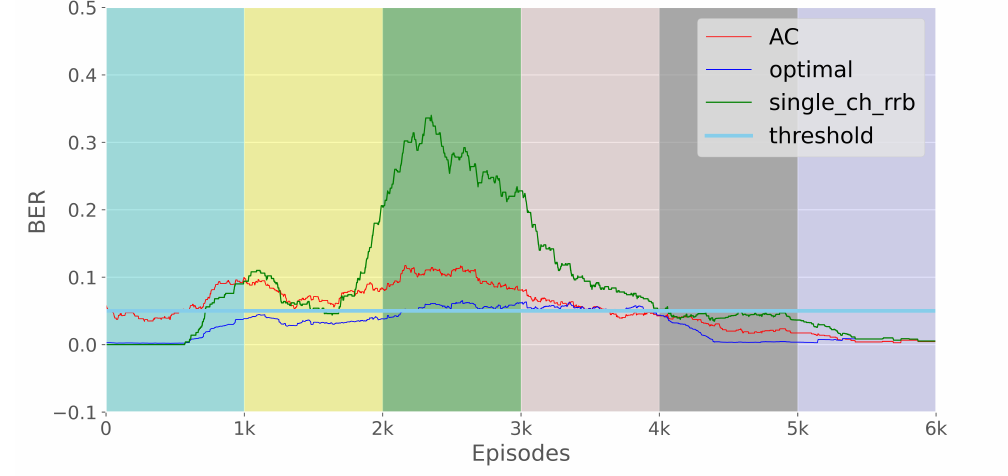
Figure 7. E2E Loss rates.